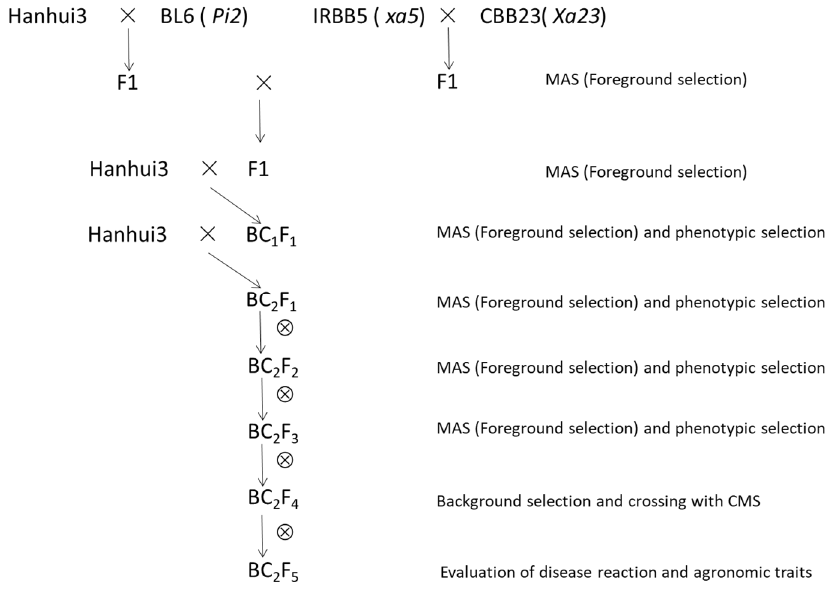
Figure 1. Schematic diagram for the development of NILs with homozygous Pi2 , xa5 , and Xa23 loci in the genetic background of Hanhui3. MAS, marker-assisted selection. CMS, cytoplasmic male sterility.